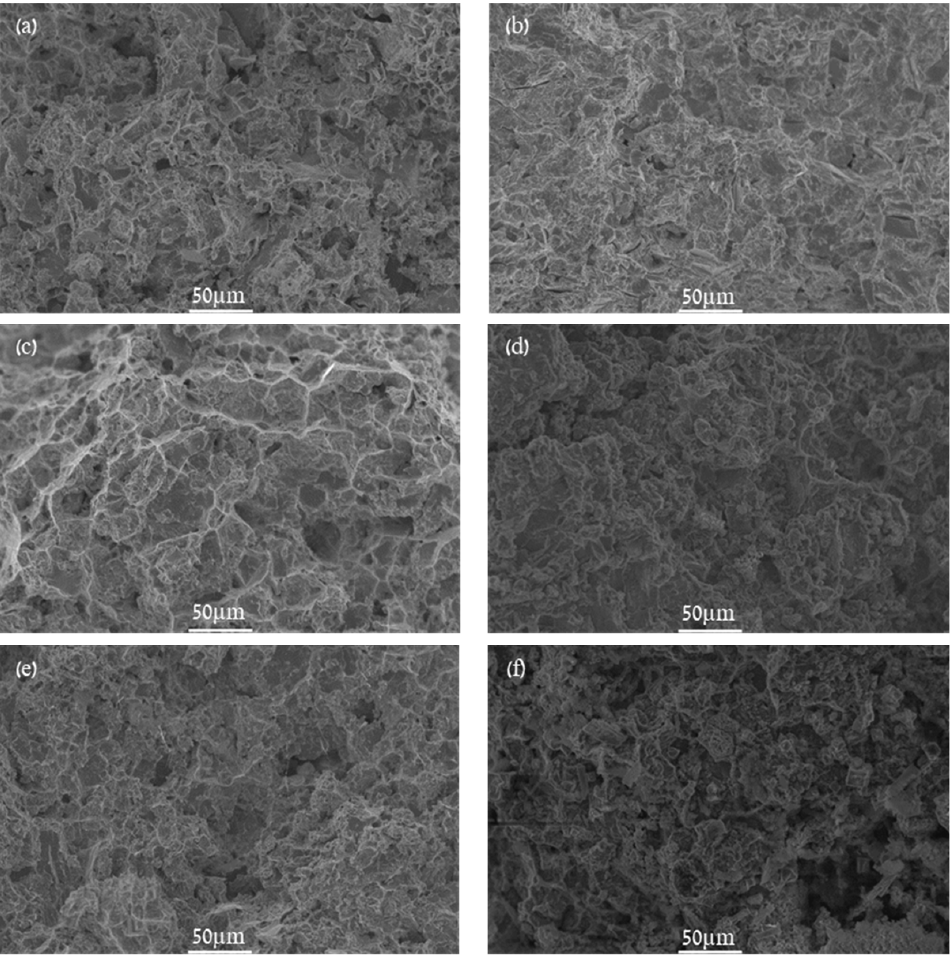
Figure 9. Typical fracture surface images after tensile testing of Zn-2%Fe-0.6%Ca alloy in PBS solution and air, respectively, at various strain rates. ( a , b ) 2.5·10 − 5 S − 1 ; ( c , d ) 2.5·10 − 6 S − 1 ; ( e , f ) 2.5·10 − 7 S − 1.